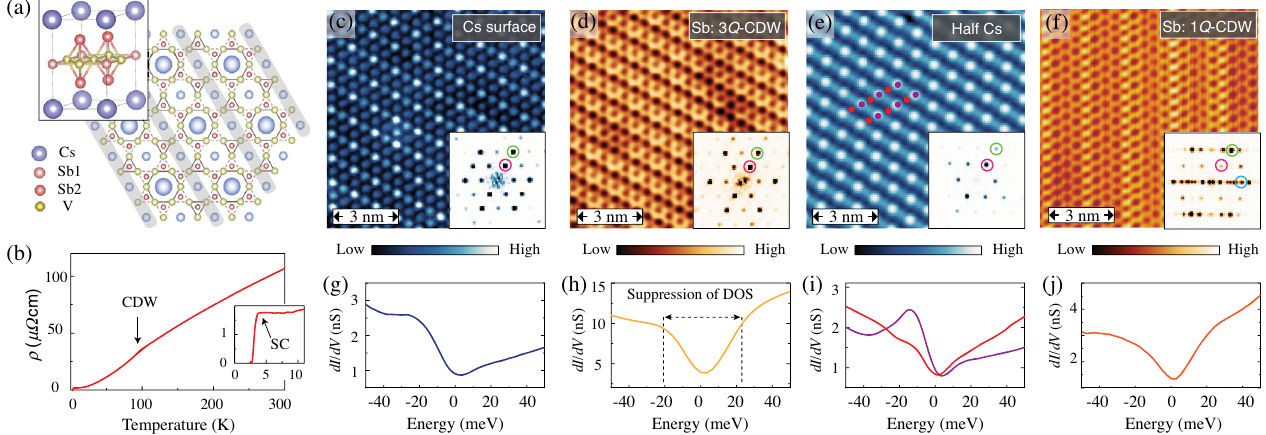
FIG. 1. (a) Crystal structure of CsV 3 Sb 5 and the illustration of a top view of the lattice. The size of Cs atoms represents the CDW modulation. (b) Temperature-dependent resistivity of CsV 3 Sb 5 . A clear anomaly occurs around 94 K, indicating the formation of charge order. The superconducting transition (marked as SC) that occurred at low temperature is shown in the inset. (c) – (e) Topographies of the Cs, Sb, and half-Cs surfaces, respectively. All of them show clear 3 Q - 2 × 2 CDW patterns. (f) Topography obtained on Sb surfaces, showing additional 1 Q modulation. This 1 Q modulation is observed on large Sb surfaces with very few Cs atoms on the top, and it becomes weaker with more surrounding Cs atoms (SM 4 [31]). The insets display the Fourier transforms of these topographic images. The lattice peak is marked by green circles, the 3 Q -CDW vector in red circles, while the 1 Q -CDW vector is shown in blue. (g) – (j) Typical dI=dV spectra for these surfaces. The purple and pink dots in (e) denote the locations where spectra are obtained for half-Cs surface. STM setup condition: (c) V S ¼ − 70 mV, I t ¼ 80 pA, (d) V S ¼ − 70 mV, I t ¼ 120 pA, (e) V S ¼ − 50 mV, I t ¼ 700